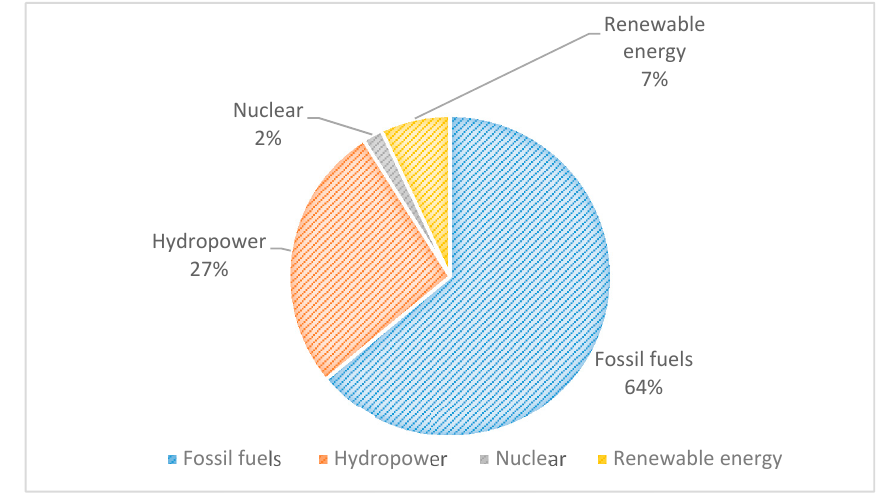
Figure 1. Pakistan Energy Statistics [63].